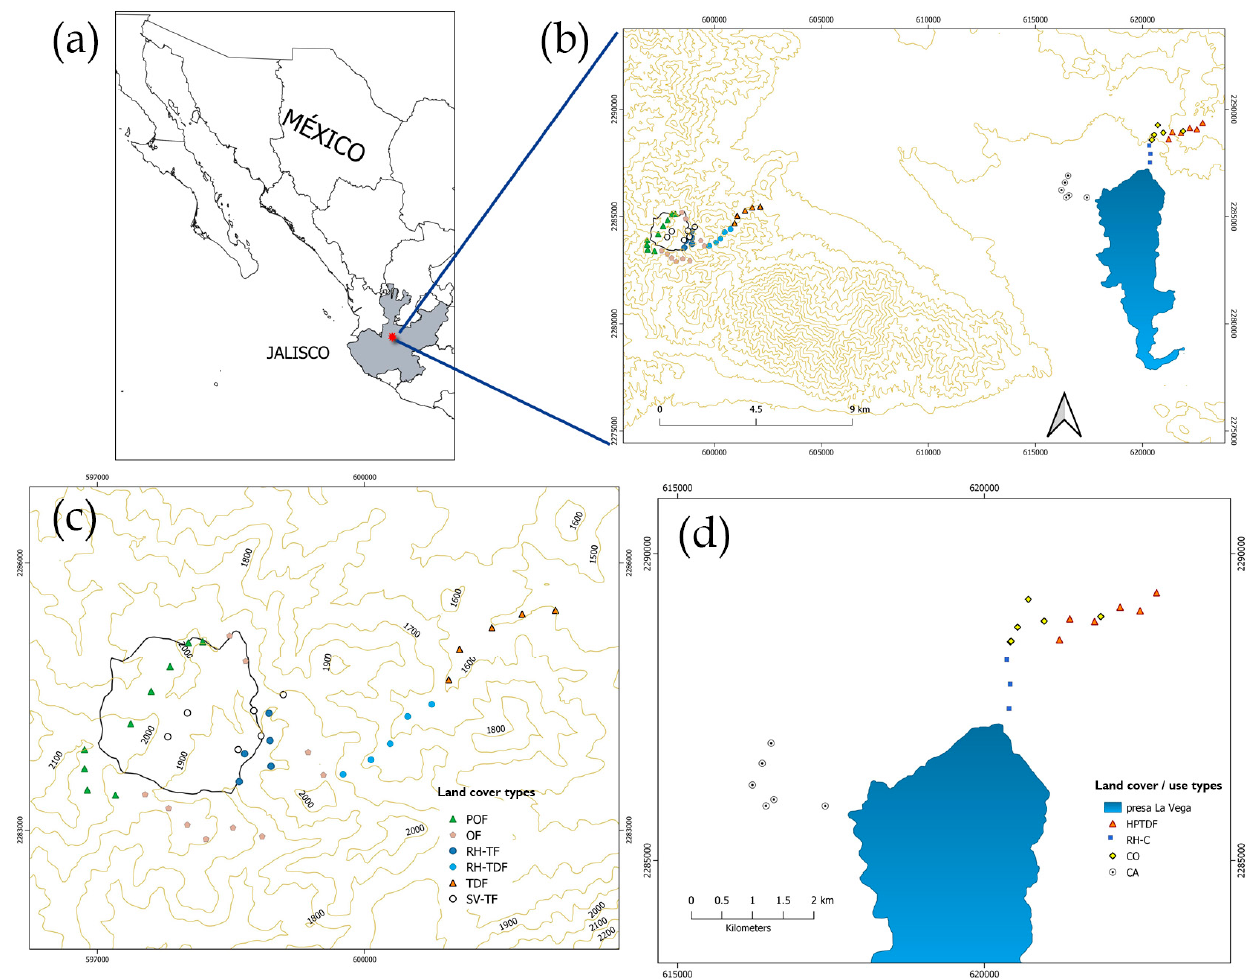
Figure 1. Study area in Jalisco, Mexico ( a ). Sampling points in the landscape ( b ). Sampling plots ( c , d ). Codes: sugar cane field (CA), riparian habitat surrounded by crops (RH-C), cornfield (CO), highly perturbated tropical dry forest (HPTDF), tropical dry forest (TDF), riparian habitat surrounded by tropical dry forest (RH-TDF), riparian habitat surrounded temperate forest (RH-TF), secondary vegetation surrounded by temperate forest (SV-TF), oak forest (OF) and pine-oak forest (POF).